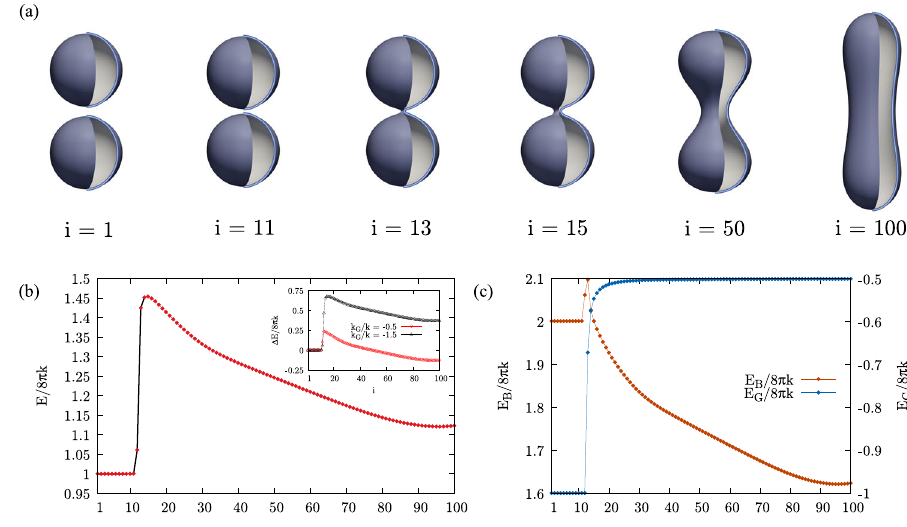
Fig. 2 The minimal free energy path. The MEP connecting two spheres of radius R * = 87.5 with a dumbbell shape, k = − k G . The path consists of vesicles ffiffiffi p with a constant area and volume and therefore with constant reduced volume v (cid:6) 1 = 2 . There is no spontaneous curvature, m * = 0. This z -axial symmetric result is obtained with the string method and the here proposed free energy functional, using a [0, 96] × [ − 245, 245] computational domain in the r * − z * plane with a grid of 144× 735 nodes per image, N = 100 images and 1/ λ ≈ 247.5. As explained in the text, this setting leads to having D ≈ 206 nm. The dimensionless quantities are however useful because, far from the moment in which the topology changes, the scale invariance is ve expected to hold. a Six vesicle shapes along the minimal energy path, identi fi ed by their image number i = ( N − 1) α i + 1, being α the string parameter (equal arc-length parameterization). From right to left we can observe the fi ssion process of the dumbbell shape into two spheres, whereas from left to right the fusion process. b The free energy (Eq. (3)), along the path. The saddle point is placed between the images i = 14 and i = 15 and consists of two spherical vesicles connected by a catenoid-like neck. The black solid line identi fi es the steepest stretch of the MEP, namely the region where a re fi nement will be carried out in the Discussion. The inset shows two additional MEPs for the same system but with k G / k = − 0.5 and k G / k = − 1.5, respectively. In this case, the energy difference with respect to the initial state, Δ E , is reported on the y-axis. c The bending and Gaussian energy contributions along the